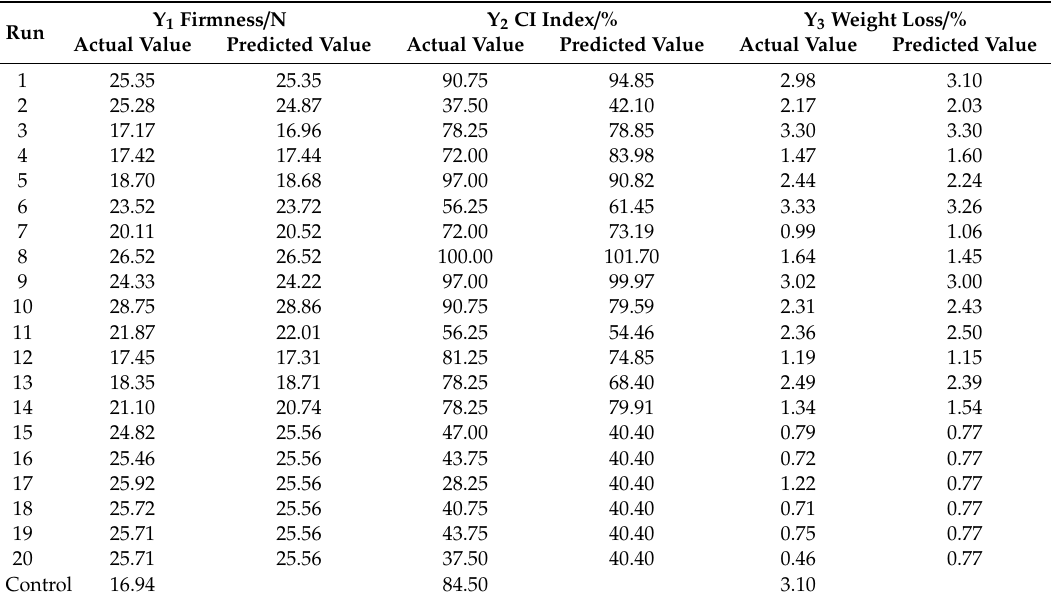
Table 3. Central-composite design with response values for firmness, CI index, and weight